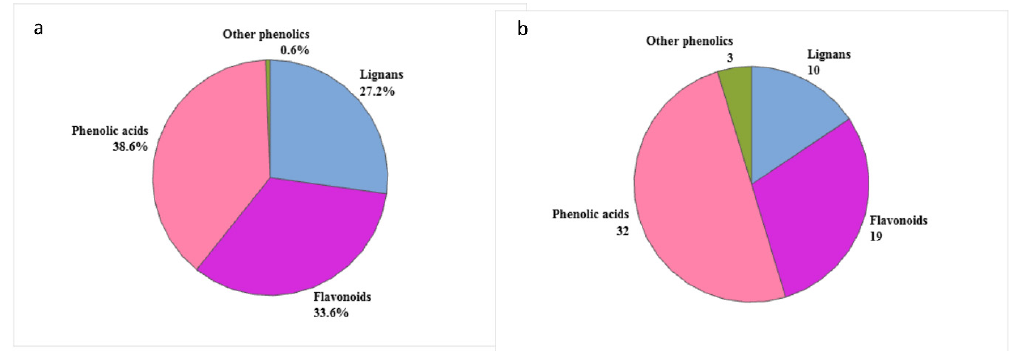
Figure 6. Phenolic compounds characterized in SG32 oil: ( a ) Relative abundance (%) and ( b ) qualitative classification (%)